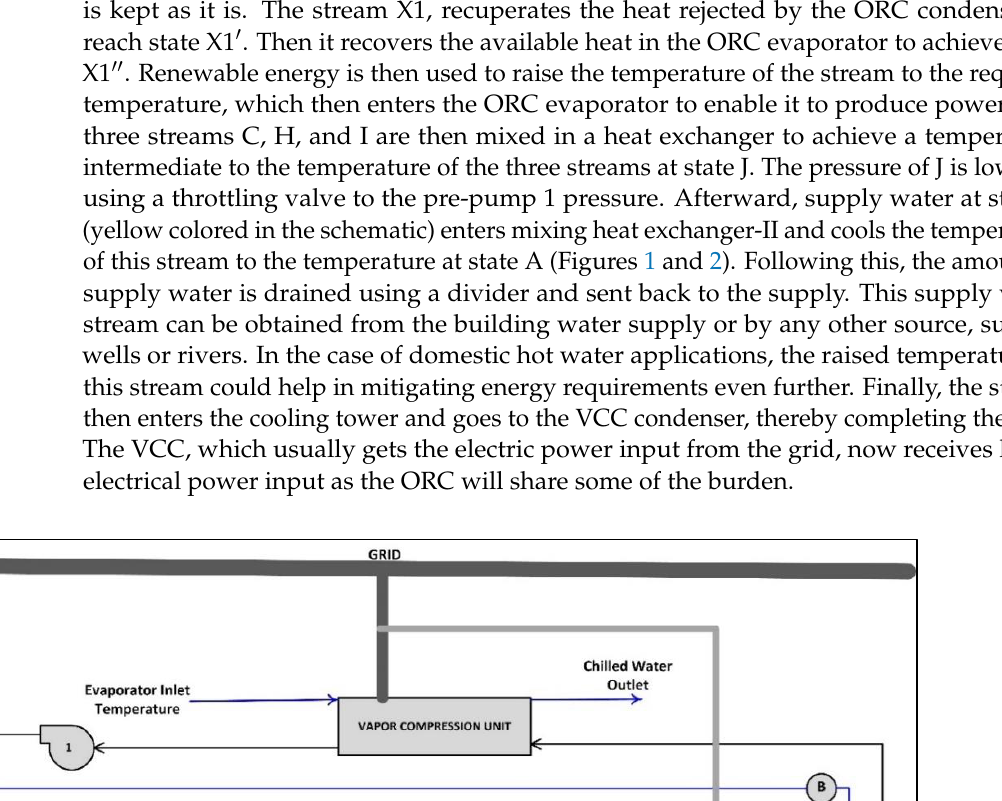
Figure 1. Conventional configuration of an air conditioning chiller.